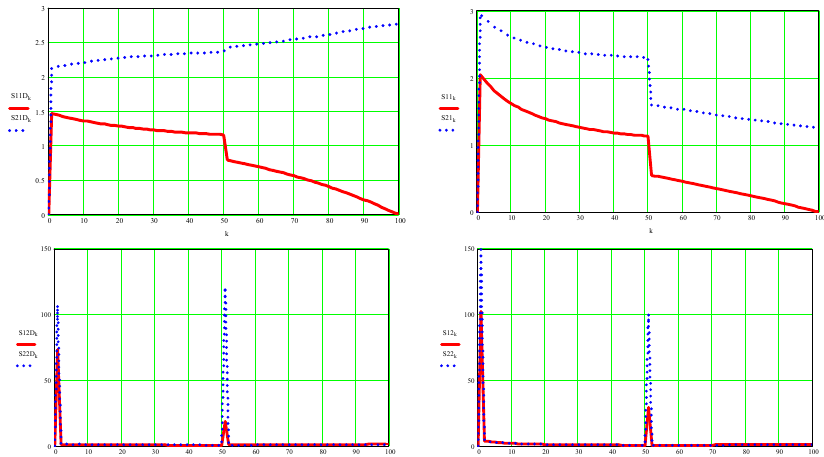
Figure A13. Here are represented the absolute velocities of point S1 (in red) and point S2 (in blue) dynamic on the left and kinematic on the right, on the top, and below are similarly represented the absolute accelerations corresponding to the same points S1 and S2 also dynamic values on the left and kinematic values on the right. (8) Original new dynamics (variable angular velocities are determined); Section 2.2. Processes 2022 , 9 , x FOR PEER REVIEW